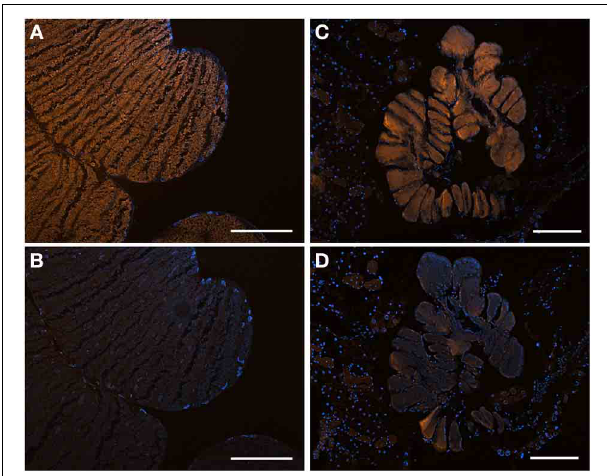
FIGURE 5 | Fluorescent in situ hybridization (FISH) images demonstrating specificity of the newly-designed probes. (A) FISH microscopy of a section through the midgut ceca of Edessa n sp. 1, embedded in, and then removed from, Steedman’s wax prior to hybridization, with the Edessa -specific probe labeled with Cy3, shown in orange, and counter-stained with DAPI, shown in blue. Signal intensity was maximum at 35% formamide, and was tested between 15–55% formamide. (B) The same section of Edessa n. sp. 1 midgut ceca, hybridized with the Sibaria -symbiont specific probe, labeled with Cy3, shown in orange, and counter-stained with DAPI, shown in blue. Note a lack of positive fluorescent signal. (C) FISH microscopy of a section through the midgut ceca of Sibaria englemani , embedded in, and then removed from, Steedman’s wax prior to hybridization, with the Sibaria -specific probe labeled with Cy3, shown in orange, and counter-stained with DAPI, shown in blue. Signal intensity was maximum at 25% formamide, and was tested between 15–55% formamide. (D) The same section of S. englemani midgut ceca, hybridized with the Edessa -symbiont specific probe, labeled with Cy3, shown in orange, and counter-stained with DAPI, shown in blue. Note a lack of positive fluorescent signal. All scales = 100 µ